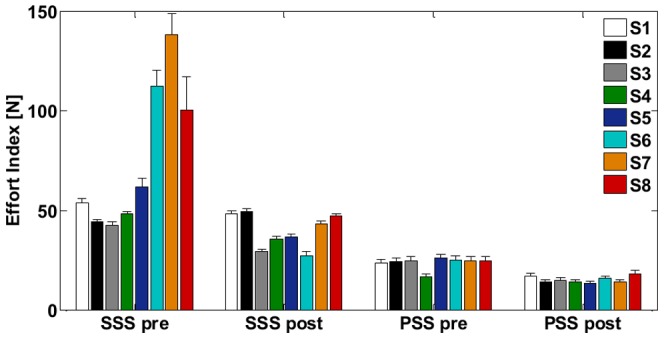
Task A: Effort Index (E).Mean effort employed by the subjects (S1 – S8) for the two strategies (SSS and PSS) during the early phase of training (SSS pre, PSS pre) and the final phase (SSS post, PSS post); whiskers represent the corresponding standard errors.